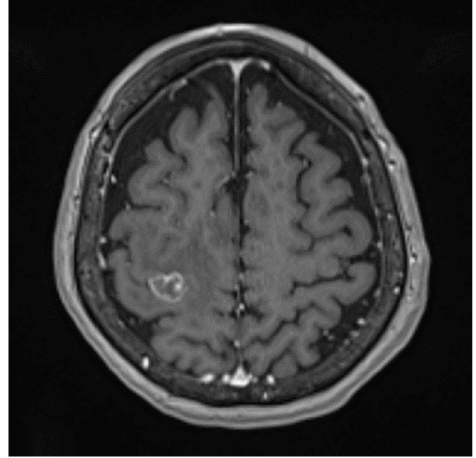
Figure 1. Solitary BrM on T1-weighted MRI with gadolinium.